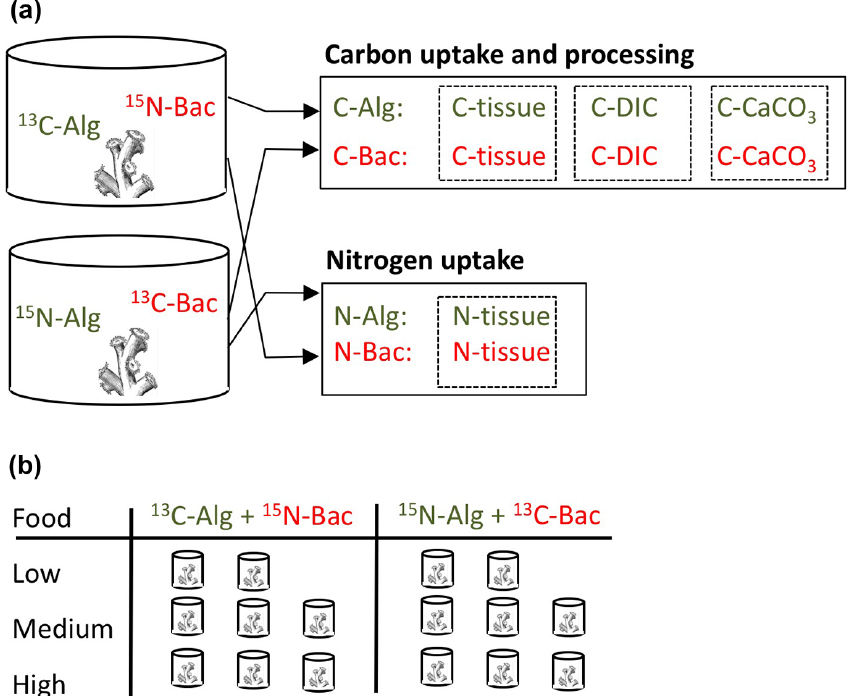
Figure 1. Experimental design of the dual-isotope labelling study. (a) Different coral fragments were exposed to a food mixture of 13 C- labelled algae ( 13 C-Alg) + 15 N-labelled bacteria ( 15 N-Bac) or to a mixture of 15 N-labelled algae ( 15 N-Alg) + 13 C-labelled bacteria ( 13 C- Bac). The N uptake in tissue (N-tissue), C uptake in tissue (C-tissue), respiration to dissolved inorganic carbon (C-DIC) and C incorporation into the skeleton (C-CaCO 3 ) was calculated for each incubation from the 13 C and 15 N transfer (see Methods). (b) Full experimental design with eight incubations for the 13 C-Alg + 15 N-Bac treatment and eight incubations for the 15 N-Alg + 13 C-Bac treatment, partitioned over a low, medium and high food concentration